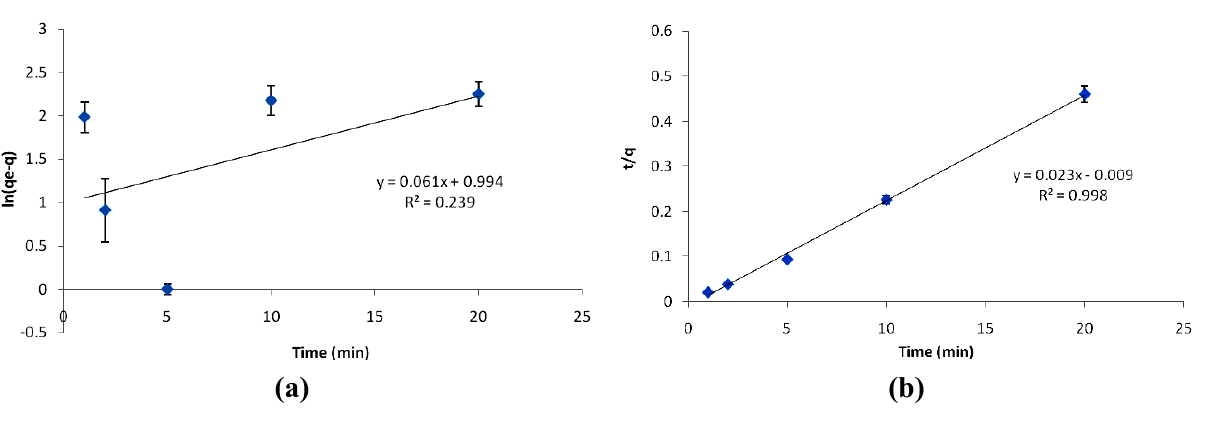
Figure 10. ( a ) Pseudo first order for sorption of melamine by MIP; and ( b ) Pseudo second order for sorption of melamine by MIP.